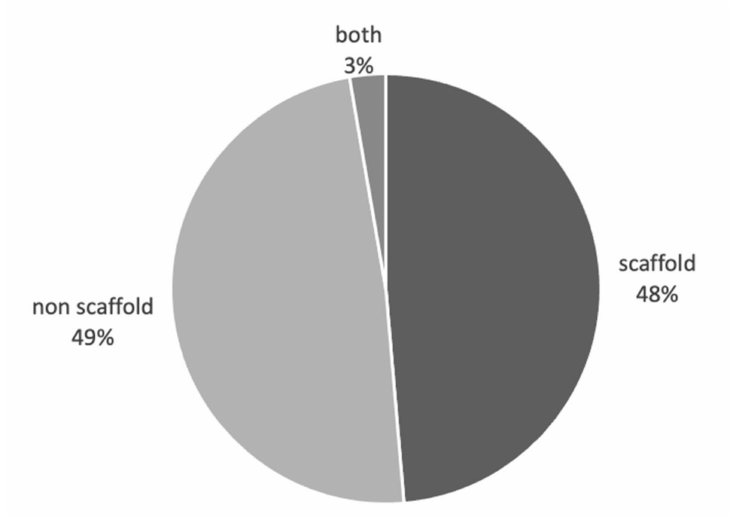
Figure 3. Biomimicry studies: scaffold vs non scaffold vs both. Proportional representation of number